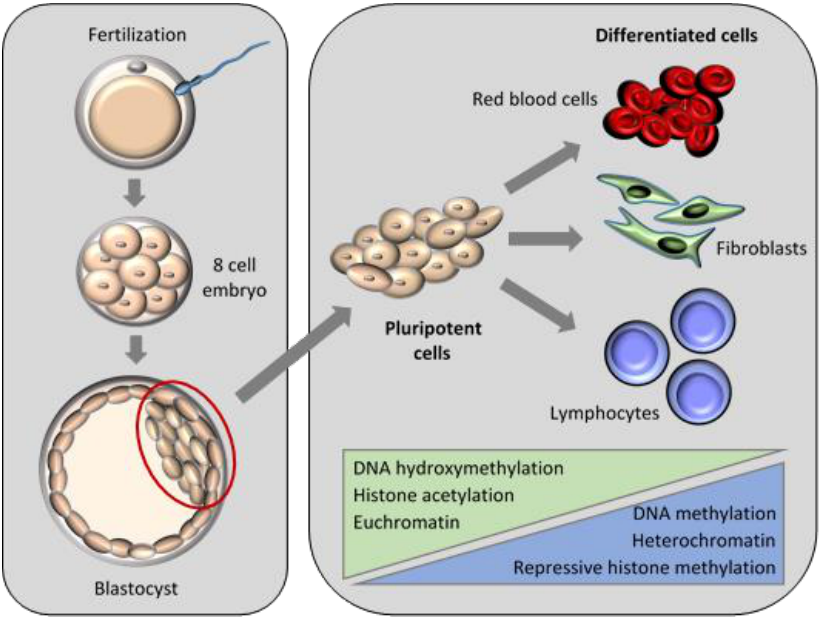
Figure 5. Epigenetic interactions during the progression from pluripotent to differentiated cells.